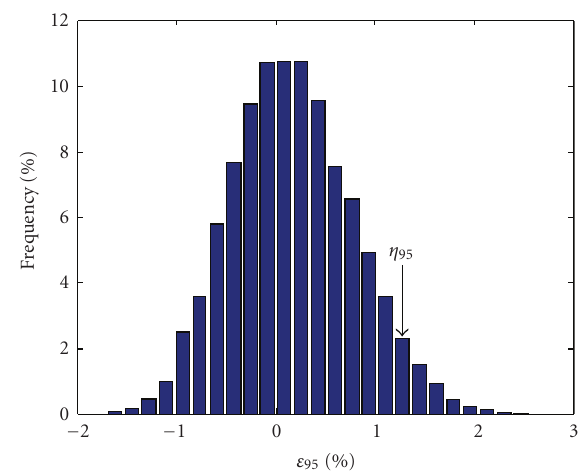
Figure 3: Distribution of 95th percentile trip setpoint errors over all core states.